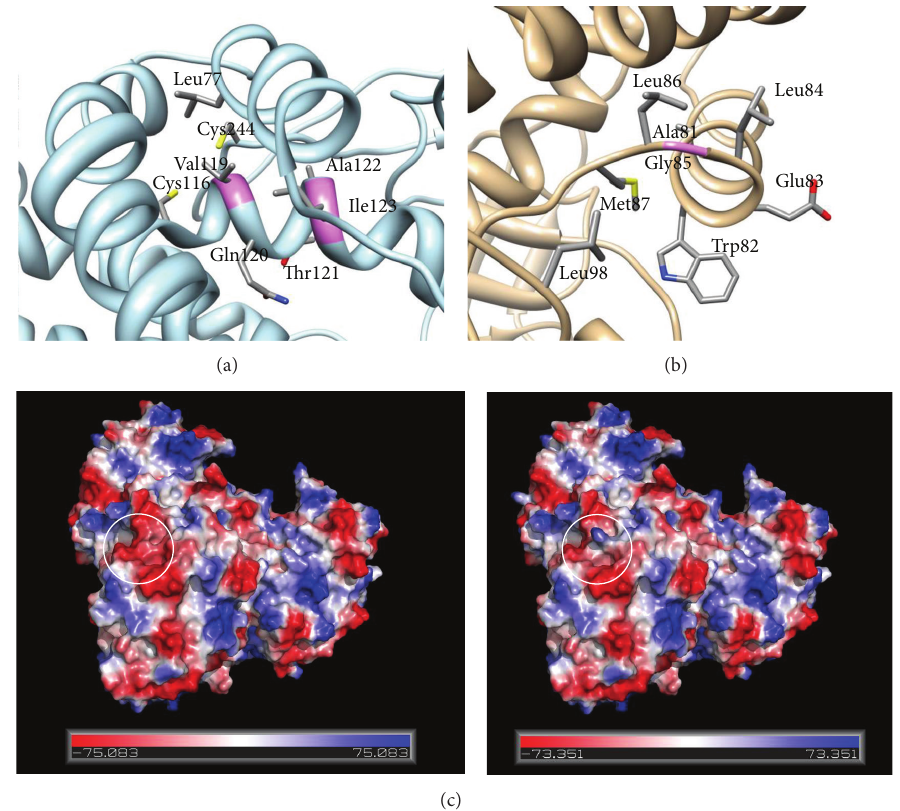
Figure 1: (a), (b) MCAD three-dimensional structure highlighting positions of the mutations. PDB structure 1EGE (ref. Pubmed ID 8823176) was downloaded and visualized in UCSF Chimera (ref. Pubmed ID 15264254). Sidechains of all amino acids with heavy atoms within 4 angstromsweredisplayedonaribbonbackbone.In(a),valine119isshowninitsenvironment,whereas(b)showsglycine85initsenvironment. The positions of the mutations are shown in violet. (c) Electrostatic surface potential of the wild-type form (on the left) and of the p.Gly85Arg mutant form (on the right). The electrostatic surface potential is indicated in red (negative charge), white (uncharged), and blue (positive charge). The figure is generated using the PyMOL Molecular Graphics System, Version 1.5.0.4 Schr¨odinger,